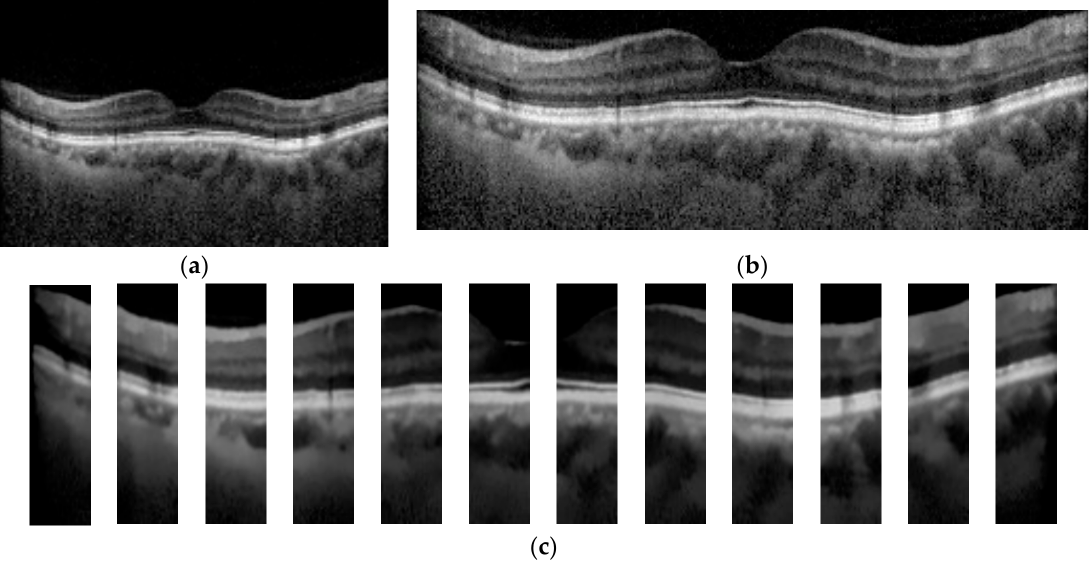
Figure 3. Example of original and preprocessed OCT image. ( a ) Original OCT, ( b ) Cropped OCT image, and ( c ) Denoised and subdivided OCT image.